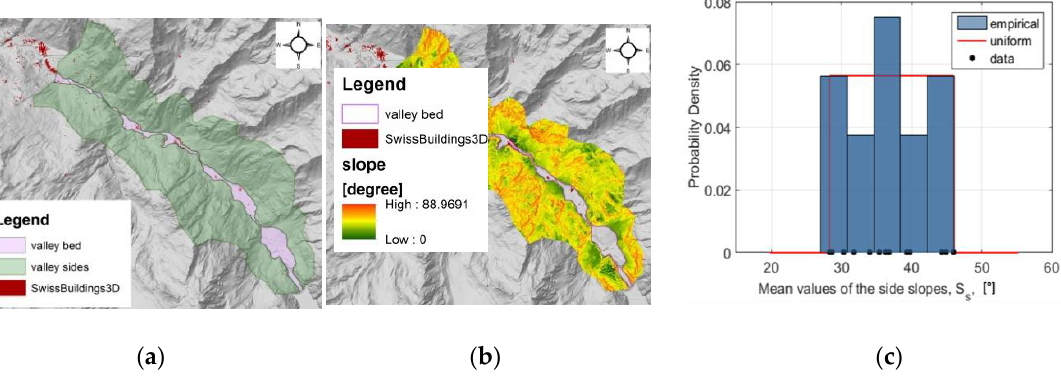
Figure 6. ( a ) Mauvoisin dam downstream area with the valley bed (pink area) and sides (green area); ( b ) slope [°] of the valley sides; ( c ) histogram of the mean values of side slopes, S s , with fitted distribution. The downstream environment is characterized by the roughness coe ffi cients M b and M s